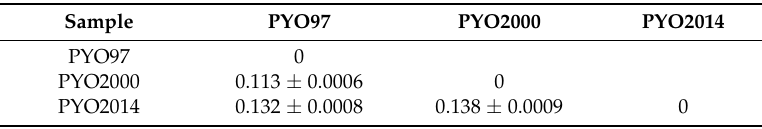
Table 10. Global mutation distances between